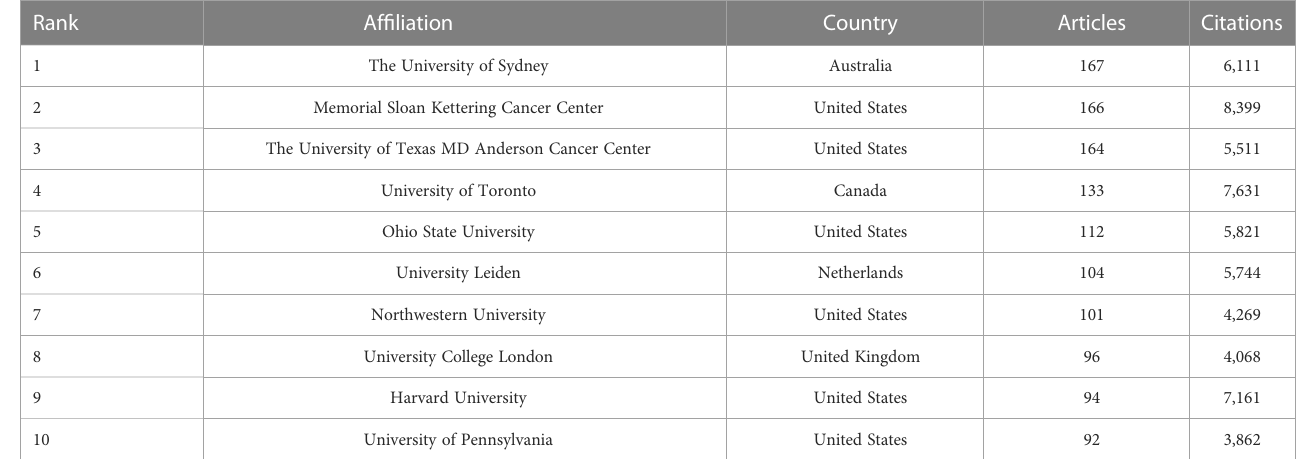
TABLE 2 The top 10 institutions that contributed to the